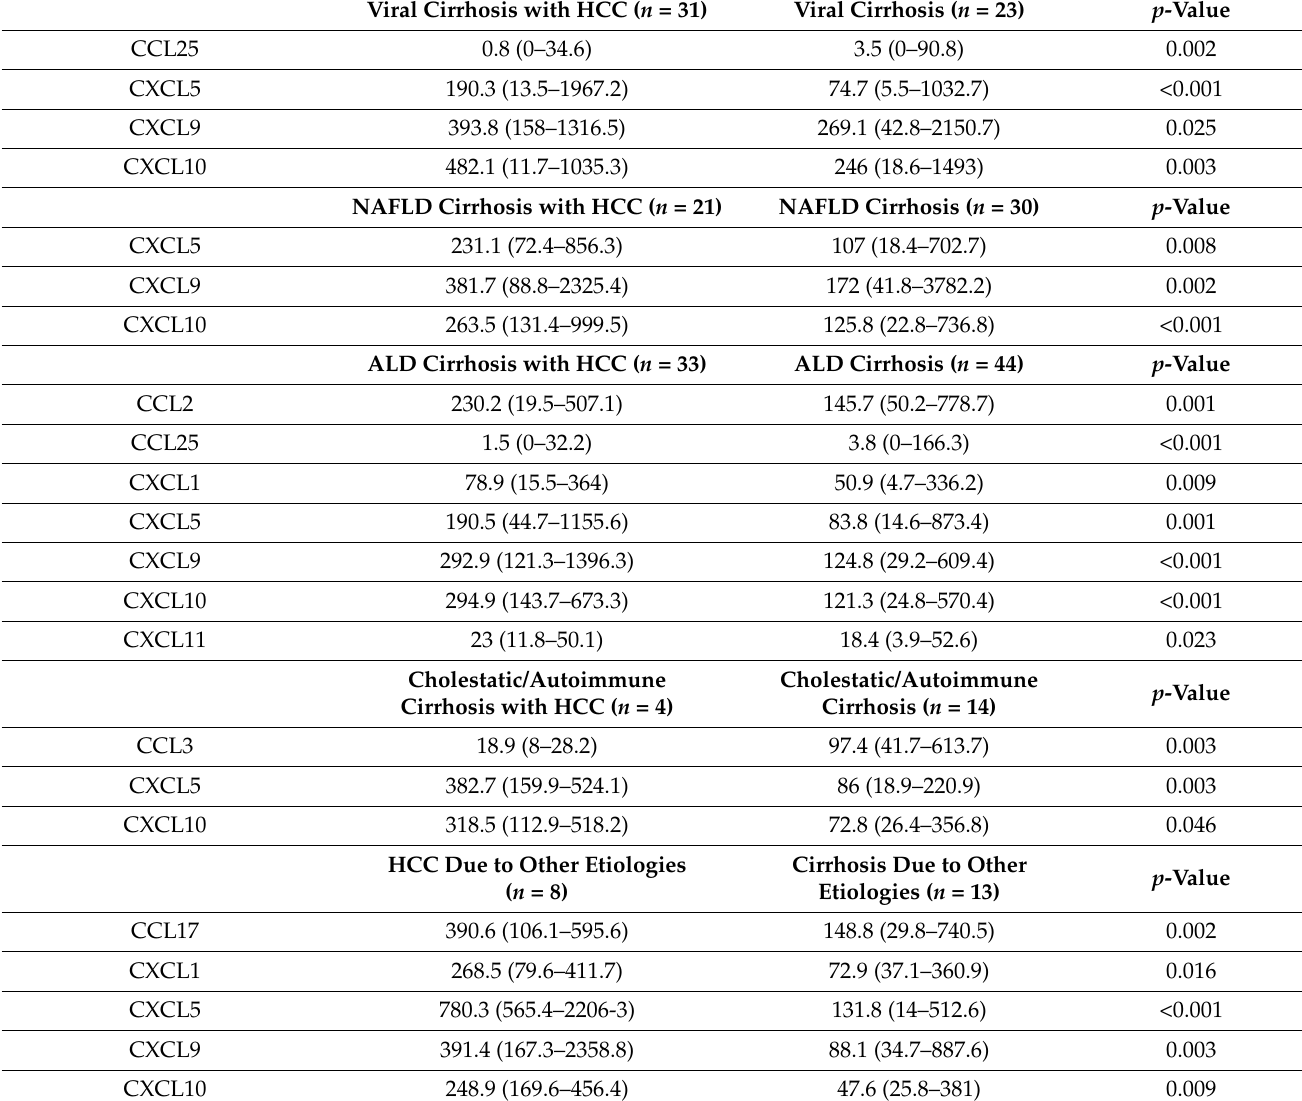
Table 2. Chemokines with significant difference in cirrhotic patients with or without HCC due to different